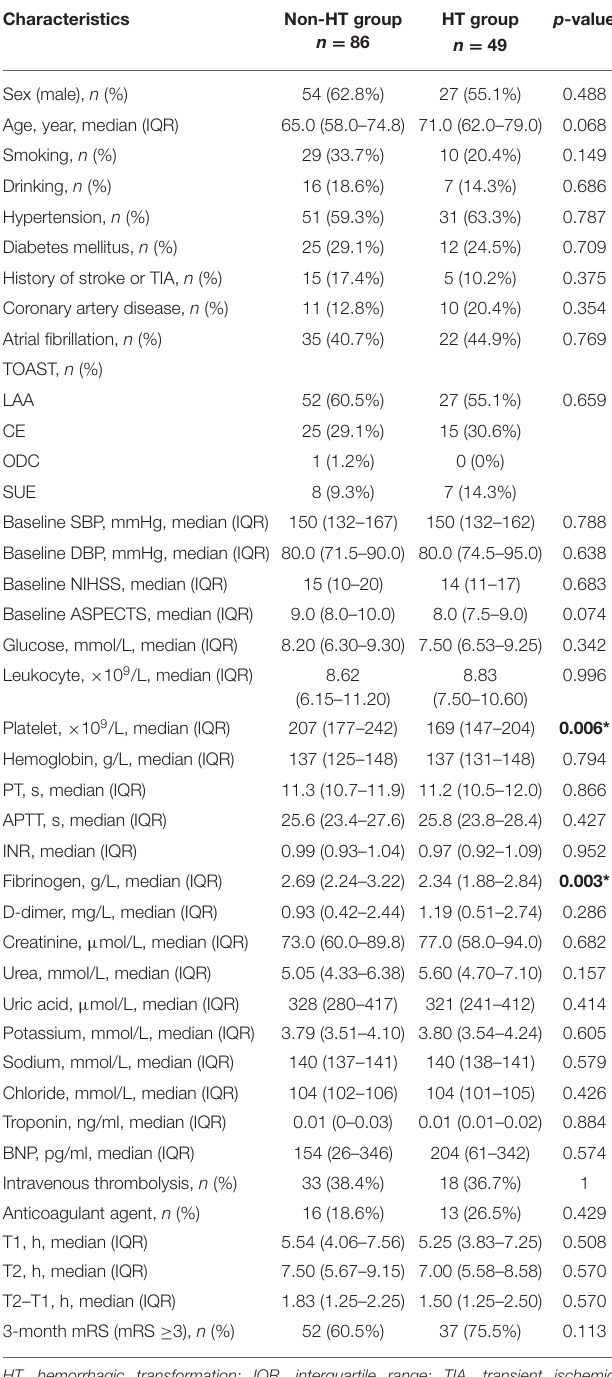
TABLE 1 | Baseline characteristics and clinical outcome of the study population.